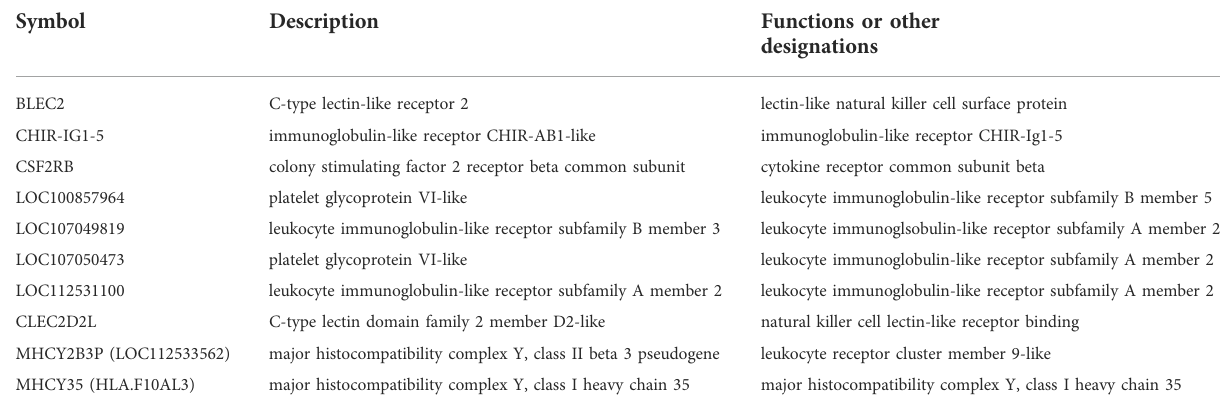
TABLE 2 Differentially expressed genes between high and low feather peckers signi fi cantly associated with KLF14 , which are involved in the immune system. Obsolete gene Symbols, due to the recent release of new genome assemblies, are shown in parentheses. Symbol Description Functions or other